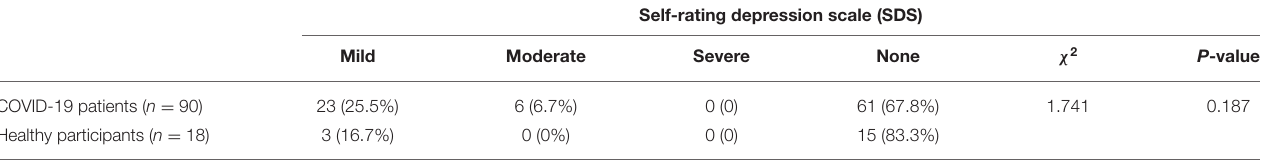
TABLE 6 | Incidence of depression reported by COVID-19 survivors and healthy participants.